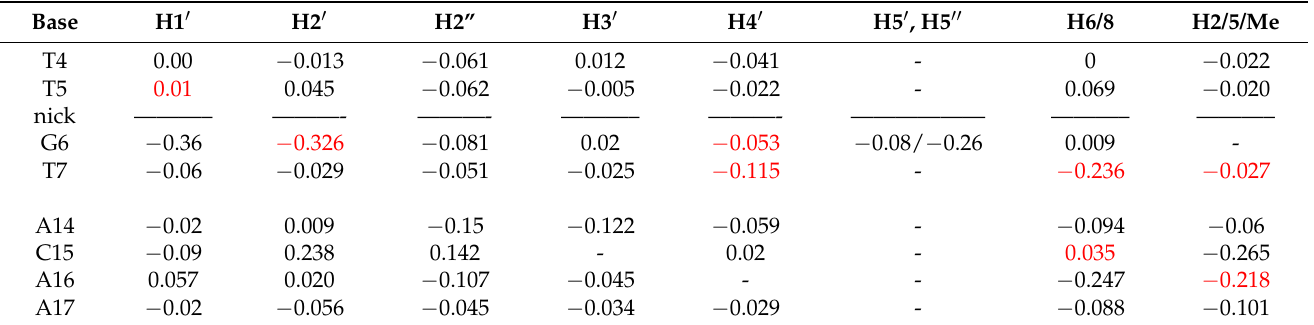
Table 5. The 1 H NMR chemical shift changes in DNA ( 2B ). Please also refer to Table S2.